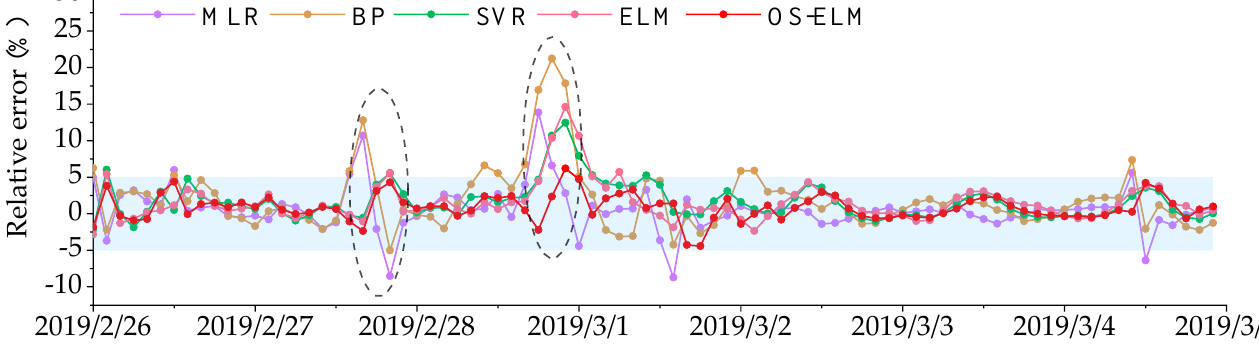
Figure 10. Comparison of prediction errors of five models.